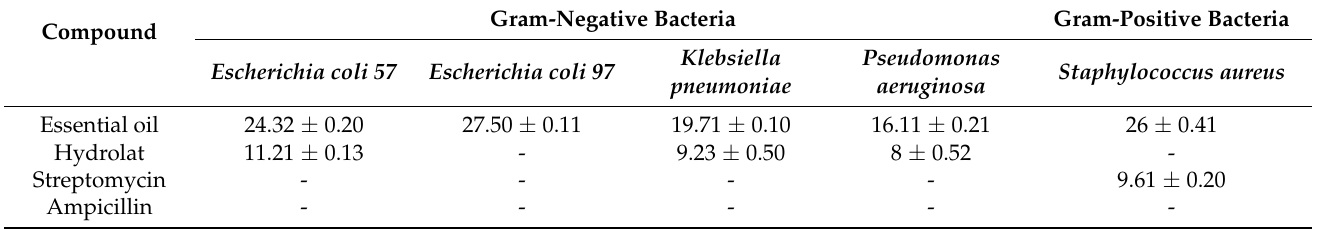
Table 4. Diameter of the inhibition zone of EO, hydrolat, and antibiotics (mm).